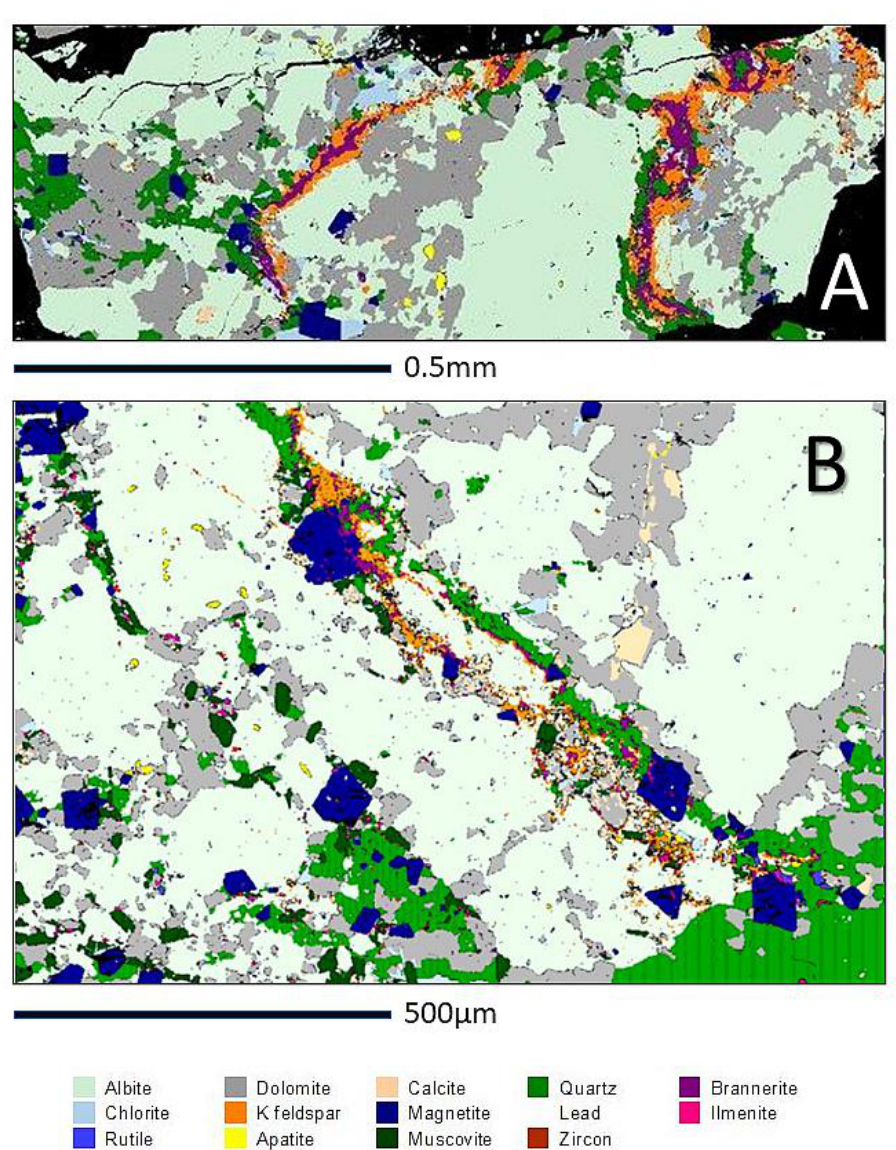
Figure 7. Mineral maps generated using hyperprobe showing brannerite-K-feldspar microveins in albitite. ( A )—Skal deposit, Mt Isa. ( B )—Valhalla deposit, Mt Isa albitite. ( A ) — Skal deposit, Mt Isa. ( B ) — Valhalla deposit, Mt Isa [12].